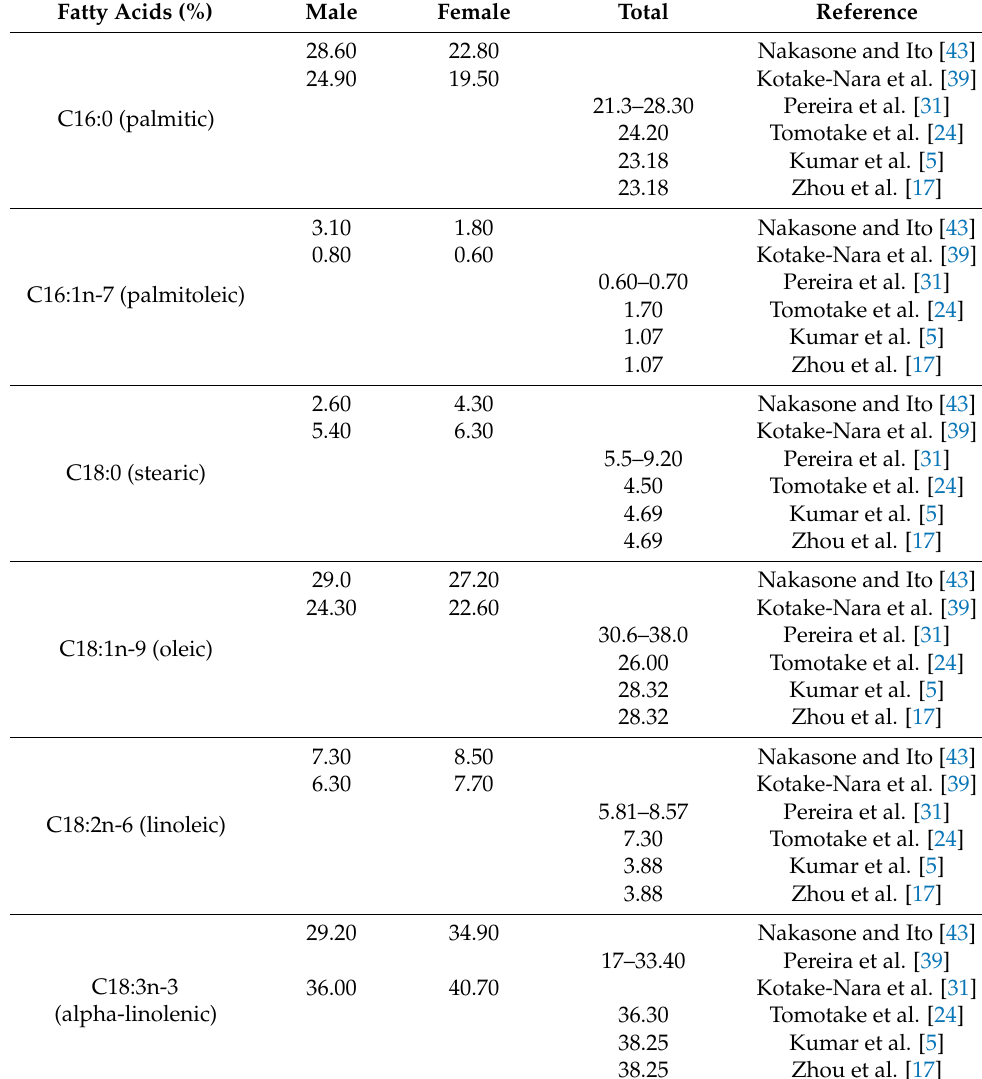
Table 2. Centesimal fatty acids composition of total lipids in